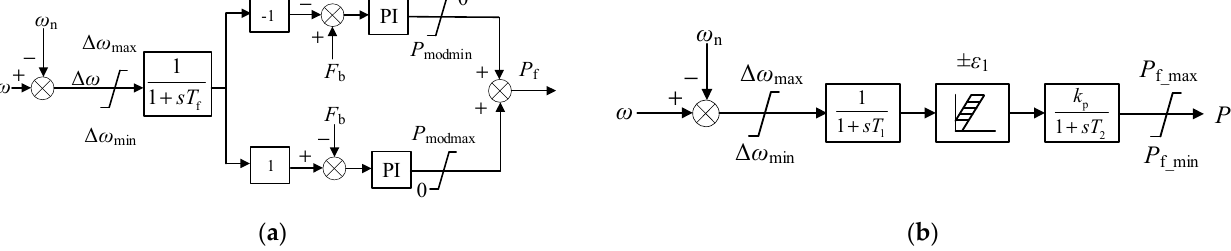
Figure 1. Typical frequency control strategies. ( a ) The principle of frequency limit control (FLC). ( b ) The principle of auxiliary frequency control (AFC). Table 1. Comparison of characteristics between different FR